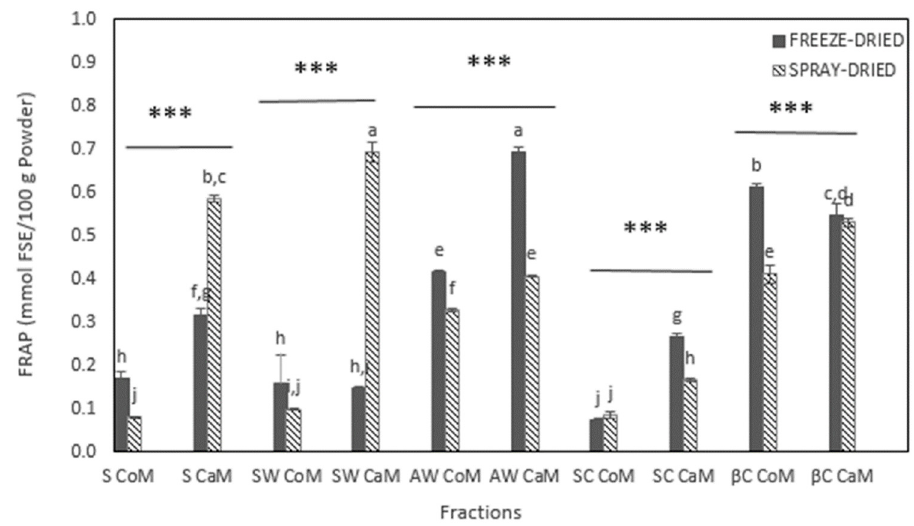
Figure 4. Ferric reducing antioxidant power (FRAP) of non-irradiated freeze-dried and spray-dried cow and camel milk powder fractions. S CoM: skim cow milk; AWCoM: acid whey from cow milk; SW CoM: sweet whey from cow milk; SC CoM: sodium caseinate, from cow milk; β C CoM: β -casein from cow milk; S CaM: skim camel milk; AW CaM: acid whey from camel milk; SW CaM: sweet whey from camel milk; SC CaM: sodium caseinate, from camel milk; β C CaM: β -casein from camel milk. Error bars correspond to 95% confidence intervals about mean values (n = 3). In each bar, different letters mean significant differences between average values ( p < 0.001). *** indicates a significant difference between the type of milk of each fraction ( p ˂ 0.001).